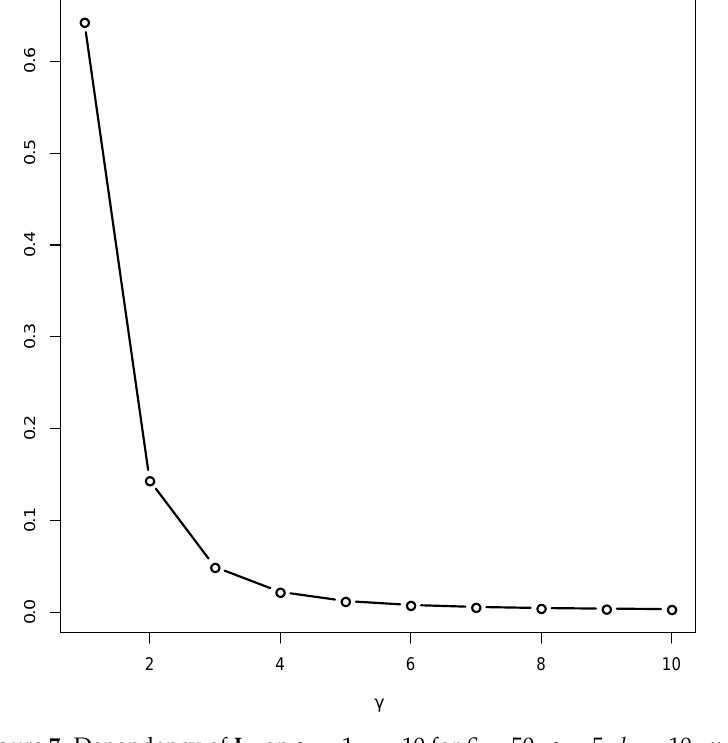
Figure 7. Dependency of L 2 on γ = 1, . . . ,10 for S = 50, s = 5, l 2 = 10, µ 1 = 7, µ 2 = 15, MMAP arrival process parameters given in